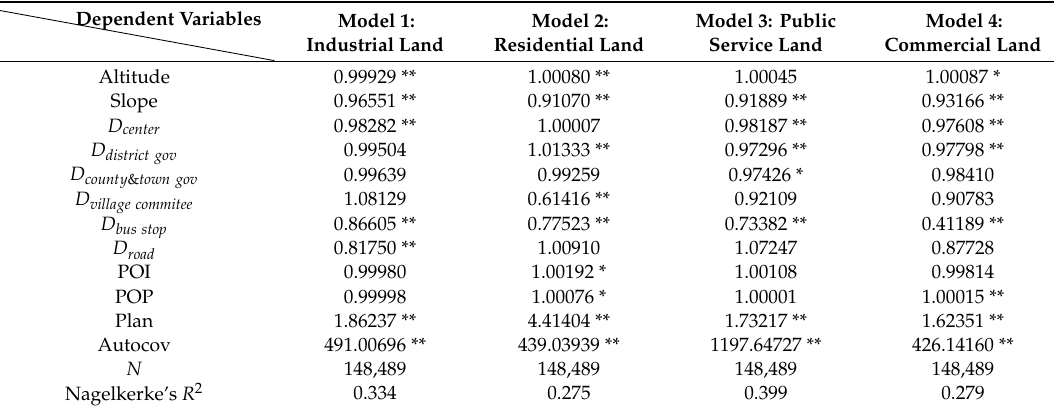
Table 7. Regression results of the four types of newly added construction